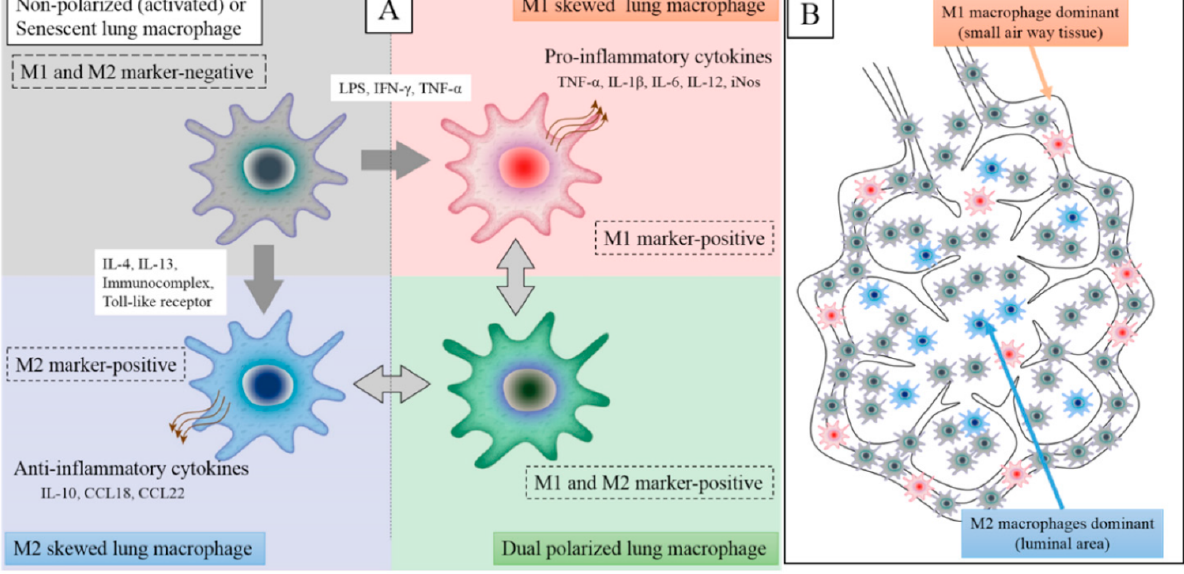
Explor Med. 2022;3:234–48 | https://doi.org/10.37349/emed.2022.00088